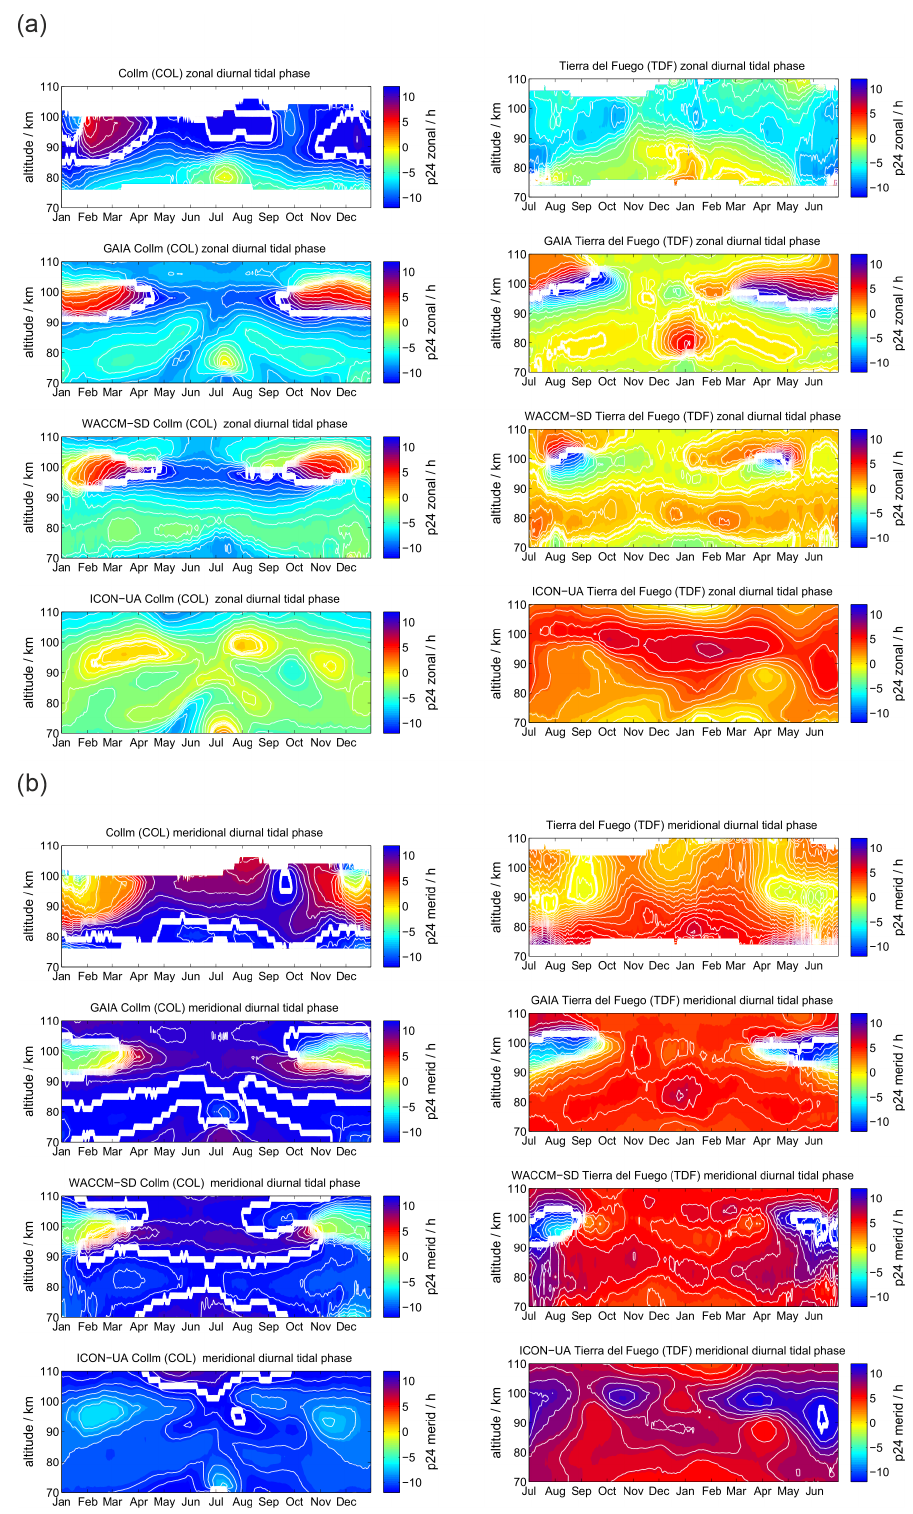
Figure 11. The same as Fig. 2, but for the diurnal tidal phases above COL and TDF.